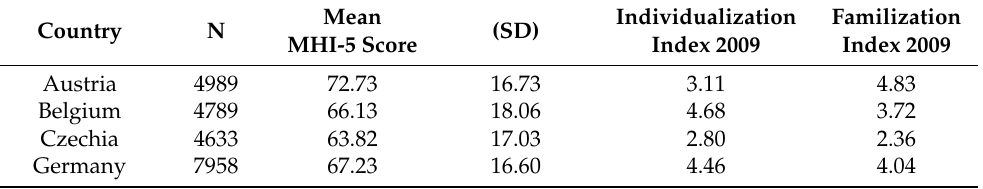
Table A2. Individual-level means of mental health and policy index scores by